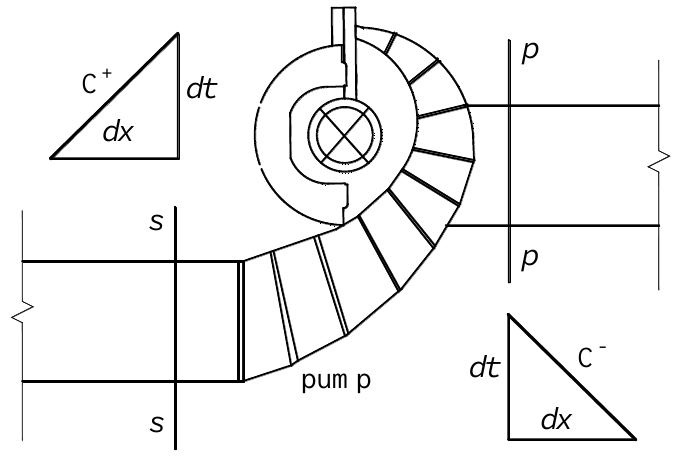
Figure 4. Characteristic lines of a pump.